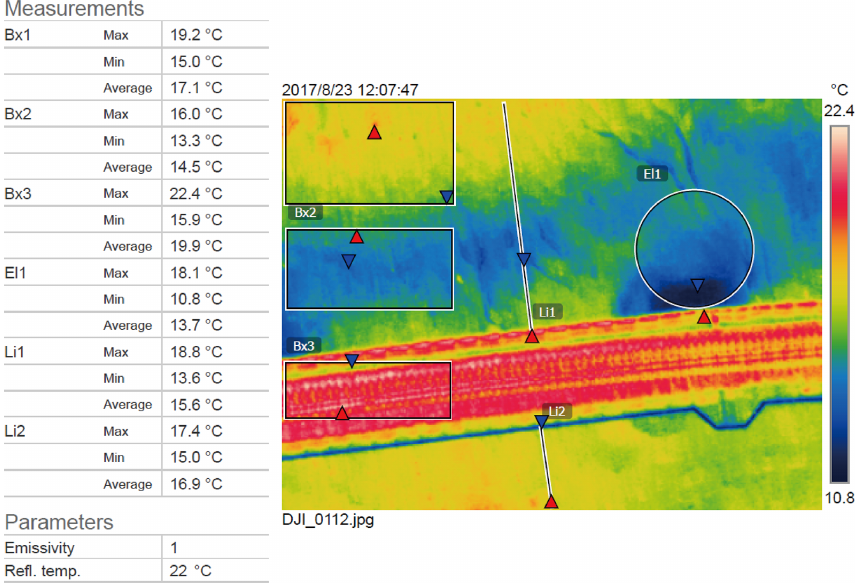
Figure 9. Analysis of the ground surface temperature using UAVs with TIR sensors, with the Qinghai–Tibet Railway as an example.